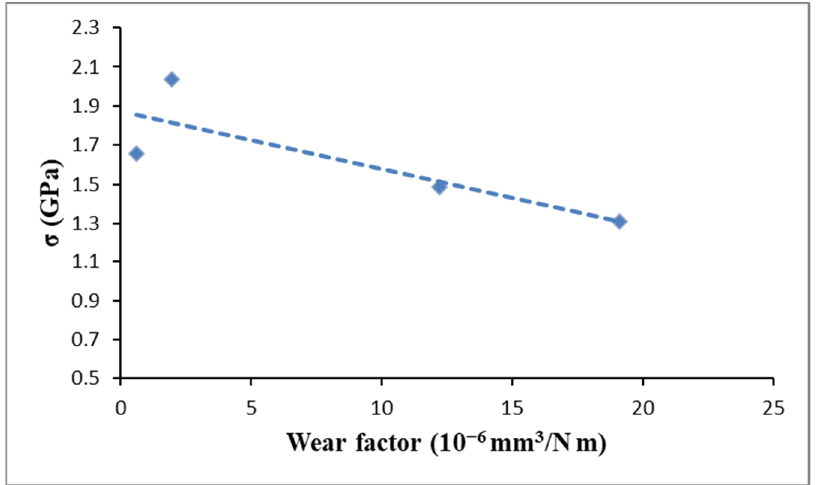
Figure 6. Correlation between factor rate and internal compressive stress measured applying a load of 5 N.